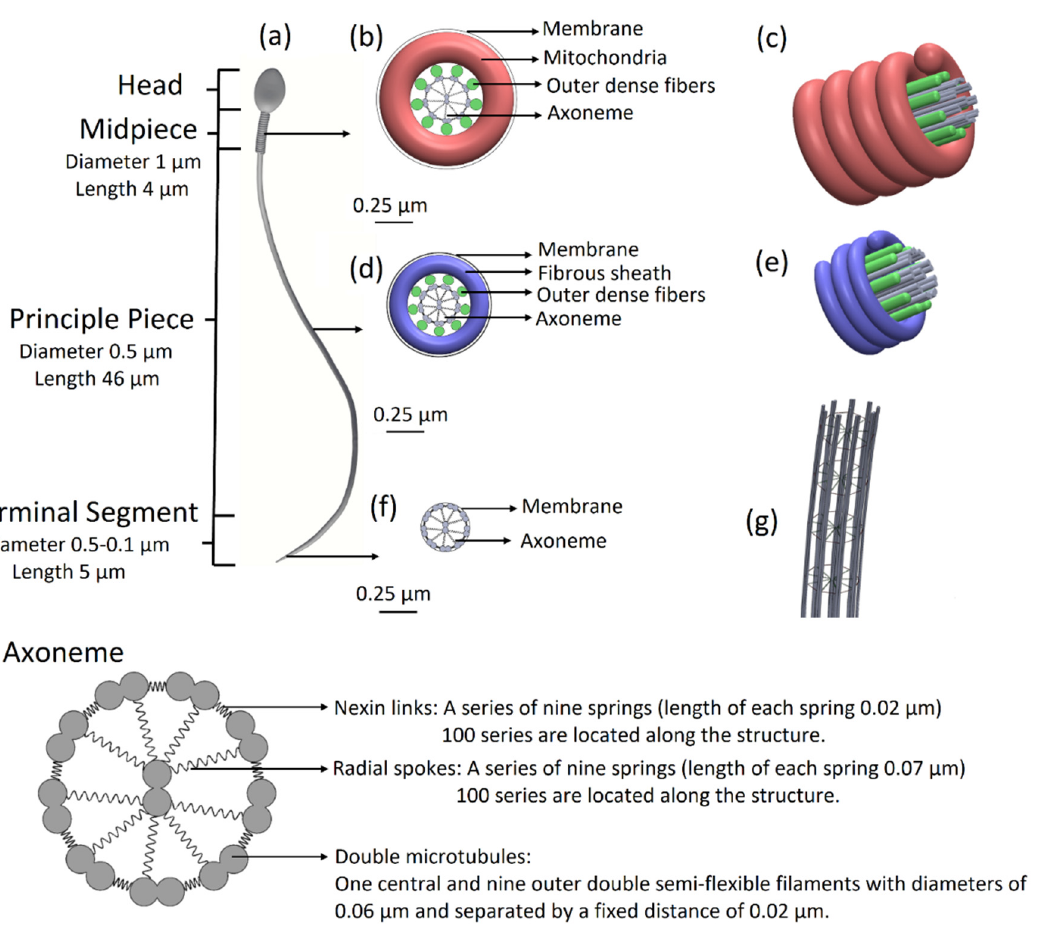
Figure 1. Sperm cell geometrical model. ( a ) Sperm model with all parts including the head, midpiece, principal piece, and terminal segment. ( b ) Midpiece in cross-section: axonemal structure surrounded by nine outer dense fibers and doubled spiral arrays of mitochondria. The midpiece is covered by a membrane. ( c ) 3D view of the midpiece. ( d ) The principal piece in cross-section: axonemal structure surrounded by nine outer dense fibers and fibrous sheath spiral and covered by a membrane. ( e ) 3D view of the principle piece. ( f ) The terminal segment in cross-section: axonemal structure covered by a membrane. ( g ) The 3D architecture of the flagellar structure model. ( h ) Axoneme in cross-section: axonemal structure: nine outer double semi-flexible filaments (microtubule doublets), linked by stiff springs (nexin links) and radial springs (radial spokes), connecting each outer filament with the central double semi-flexible filaments and covered by a